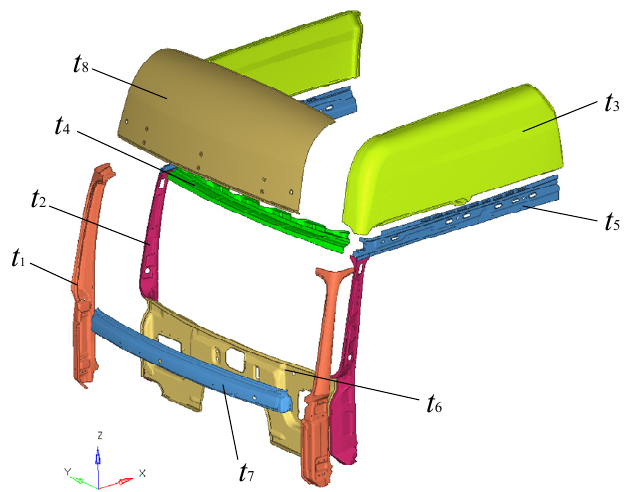
Figure 13. Illustration of key design variables. Table 1. Key design variables and value range.